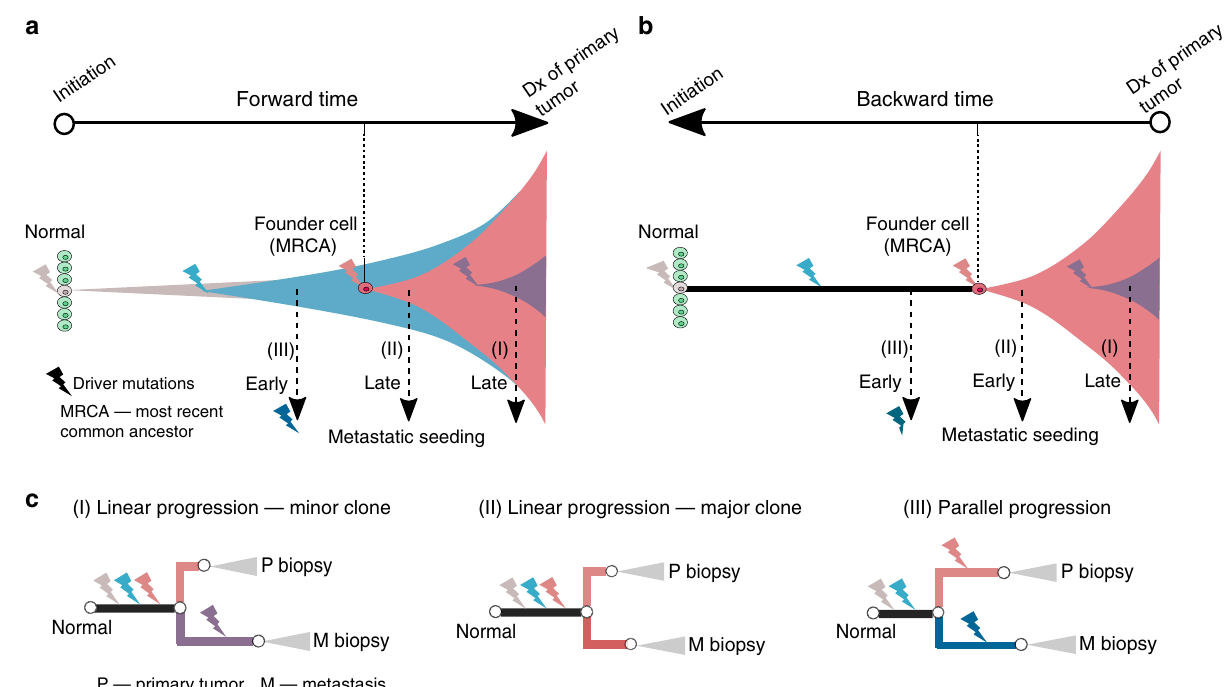
Fig. 1 Models and chronology of metastatic dissemination. a Forward-time models and the chronology of metastatic dissemination. Metastasis occurs late in linear progression (either(I) — minor clone model or (II) — major clone model) and early in the parallel progression model (III). b Backward-time models and the chronology of metastatic dissemination. Metastasis commonly occurs several years prior to detection of the primary tumor, consistent with early dissemination from the major or dominant clone after emergence of the cancerous founder cell. c Driver gene heterogeneity in bulk sequencing of paired primary tumors and metastases under different models. In the minor clone model (I) of linear progression, metastases typically harbor “ private ” driver mutations which are present at low frequency in the primary tumor and undetectable in bulk sequencing. In contrast, the origin of metastasis from a major clone (II) typically leads to driver gene homogeneity. Parallel progression (III) characteristically leads to high driver gene heterogeneity where both the primary tumor and metastasis acquire private driver mutations after dissemination. Dx, Linear progression — major clone model . Genomic data from